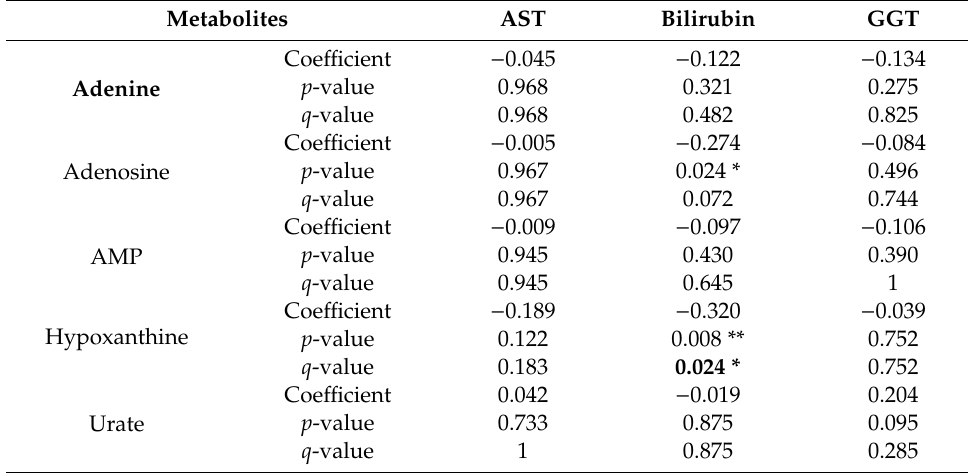
Table 3. Partial correlation analysis (Pearson’s correlation, adjusting for patient age) between the levels of five selected metabolites and those of liver enzymes; p -values were represented as q -values after applying Benjamini–Hochberg correction; * p or q < 0.05, ** p or q <